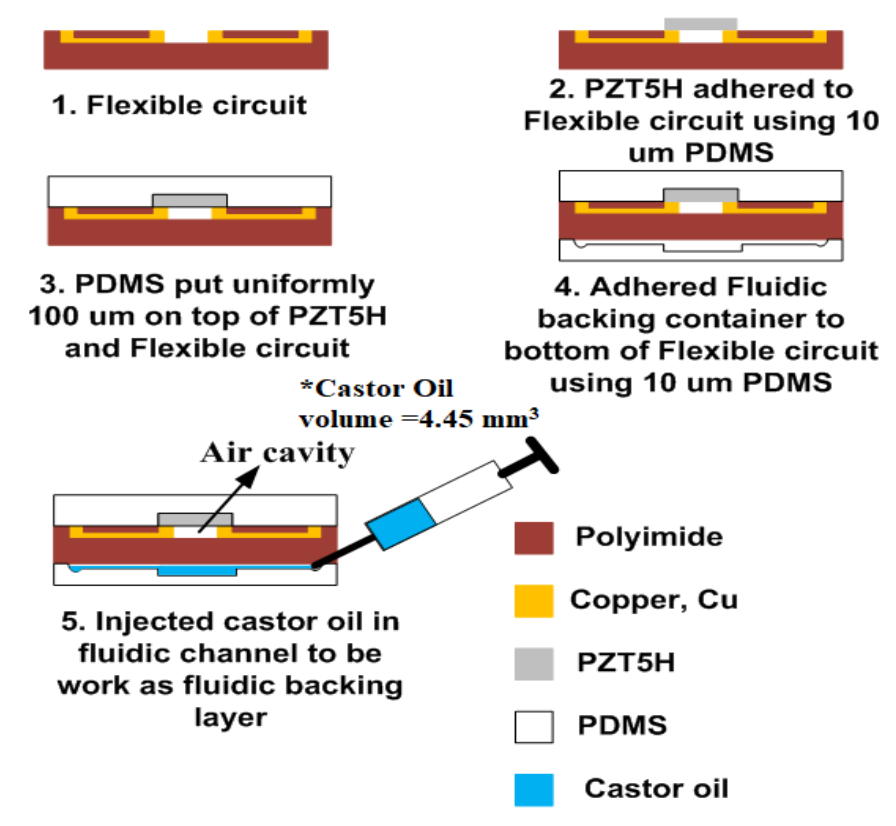
Figure 4. Fabrication process flow of PMUT .